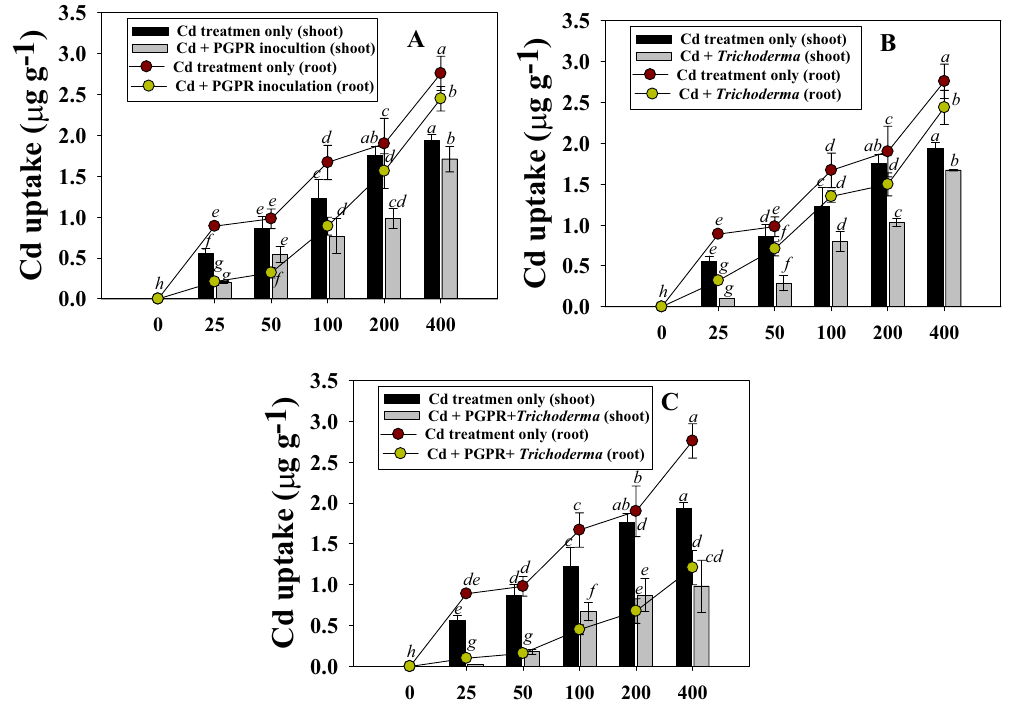
Figure 6. Uptake of Cd in chickpea plants treated with different concentrations ( 0, 25, 50, 100, 200 and 400 μg Cd kg −1 ) of Cd and inoculated with PGPR-7 ( A ), Trichoderma sp. T-4 ( B ) and PGPR-7 + Trichoderma sp. T-4 ( C ). Each bar and line diagram represents the mean of three replicates ( n = 3). Corresponding error bars represent standard deviation (S. D.) of replicates. Different letters represent that mean values are significantly different according to DMRT